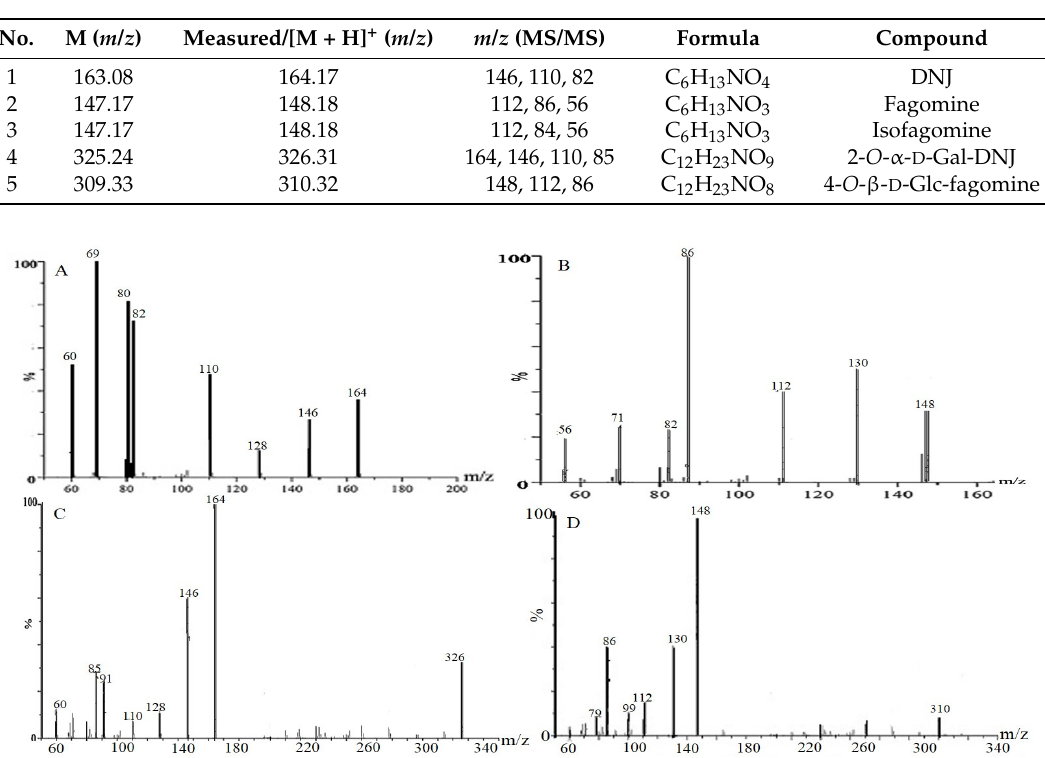
Table 1. Spectrometric data of compounds found in mulberry leaves.